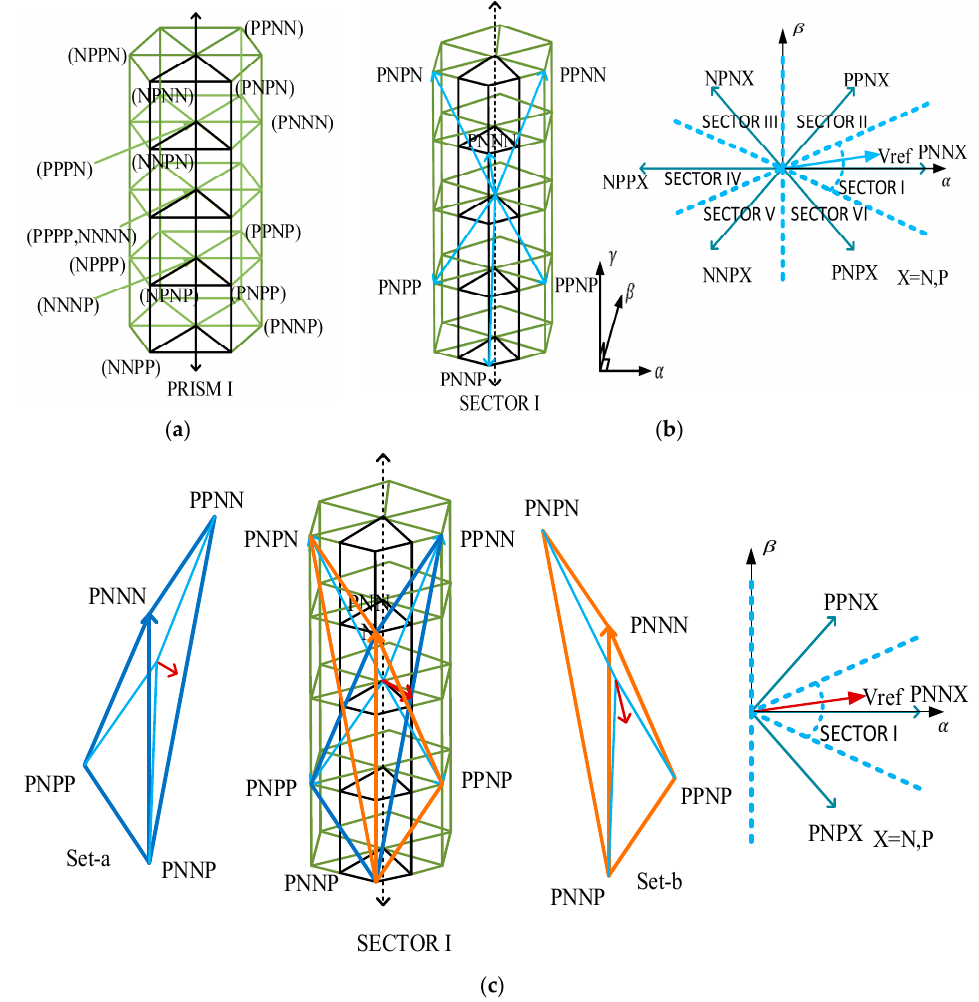
Figure 2. ( a ) Switching vectors and prisms ( b ) Projection of a sector on the αβ coordinate ( c ) Sector identification with near state vector selection (NSV).